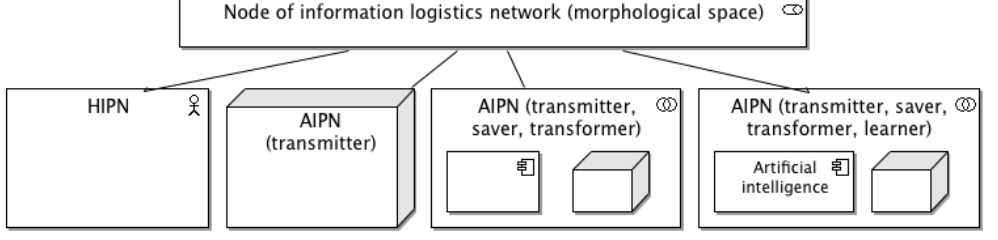
Figure 5. Types of nodes of information processing (morphological